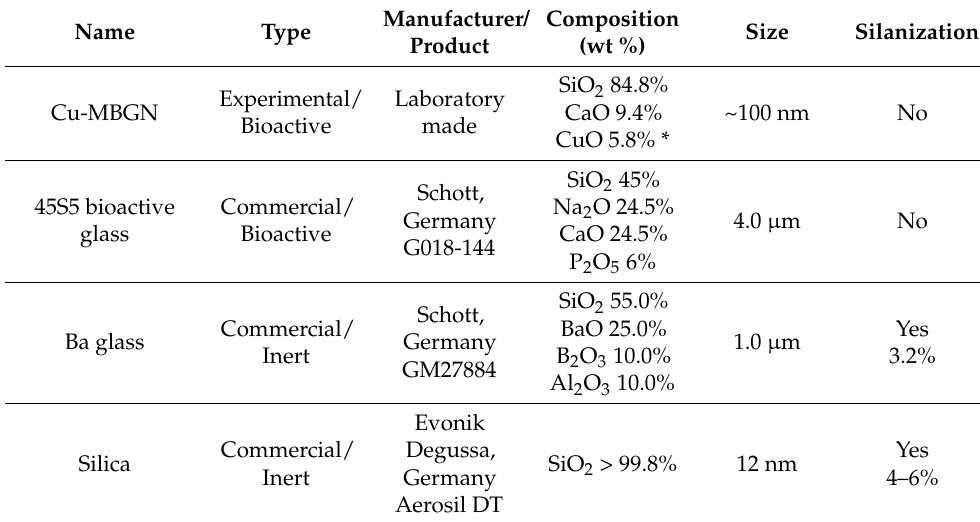
Table 1. Characteristics of fillers used in the present study. Data provided by the